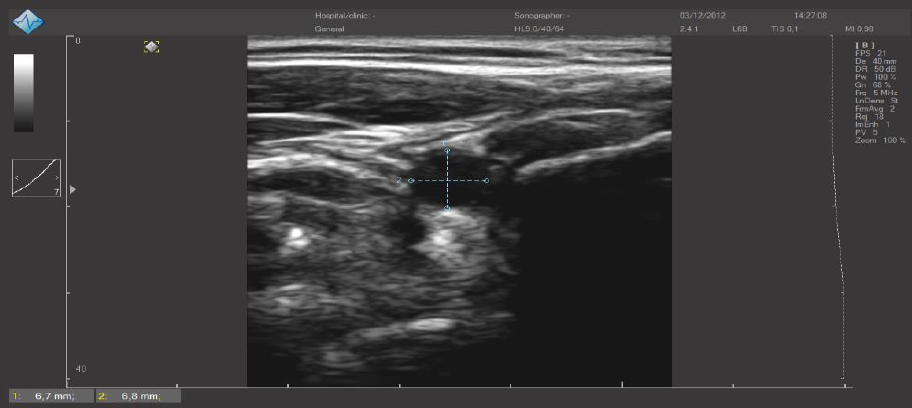
Figure 1. Typical manually-driven measurement in ultrasound (US) software (TeleMed) to determinate the diameter of the